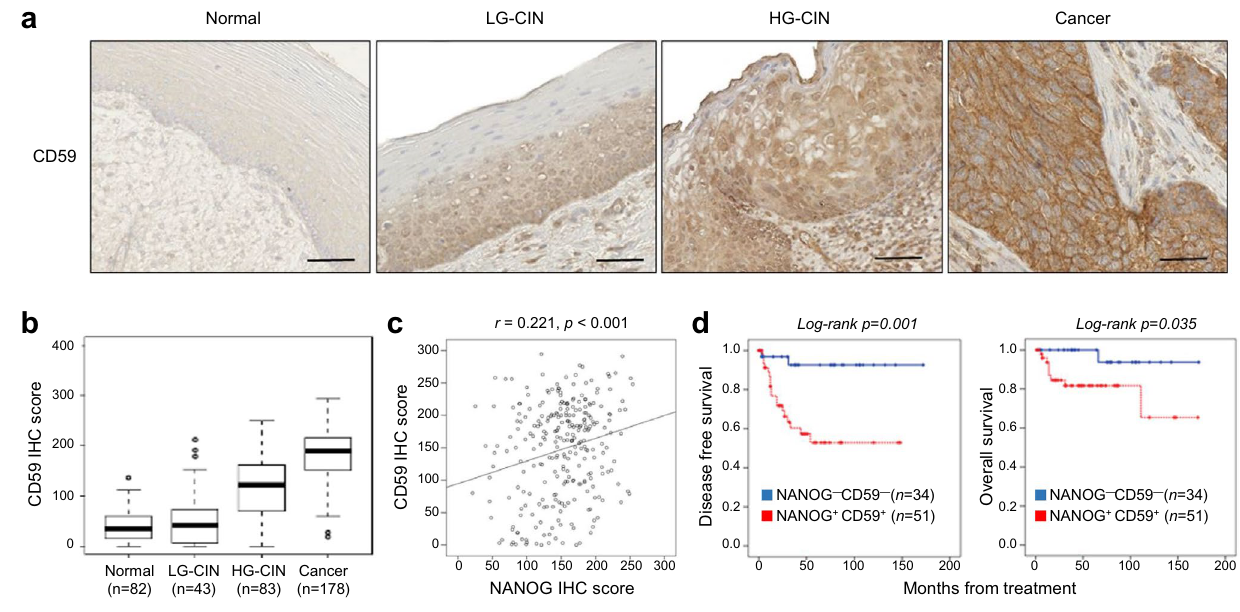
Figure 4. NANOG and CD59 expression in human cervical neoplasia specimens. ( a ) Representative image of immunohistochemical staining of CD59 in the cervical tissue from normal, low grade CIN (LG-CIN), high grade CIN (HG-CIN), and cervical carcinoma (cancer) patients. Scale bar shown is 100 µm. ( b ) Box plot depiction of immunohistochemical staining data shows that the CD59 level was increased during tumor progression. Differences in protein expression were statistically tested using the Kruskal–Wallis test. ( c ) NANOG staining score (IHC score) was compared with CD59 IHC score using a simple scatter plot. NANOG was positively correlated with CD59 (Spearman’s rho = 0.221, p < 0.001). ( d ) Patient with the combined NANOG + /CD59 + level showed a significantly worse disease-free survival and overall survival than patients with the NANOG - /CD59 - level (log-rank test, p = 0.001 and p = 0.035, respectively). The cut-off value of NANOG and CD59 were 160 and 178,